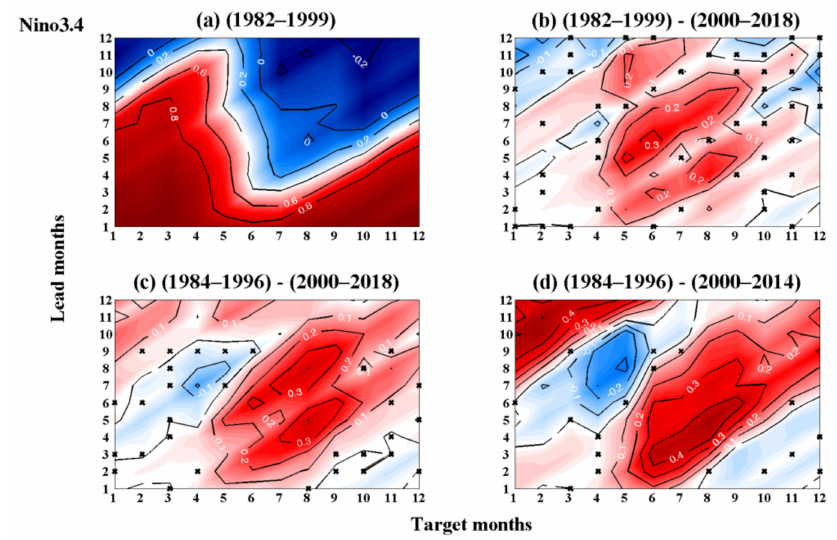
Figure 4. As in Figure 2, but for autocorrelations of the observed Niño3.4 index.